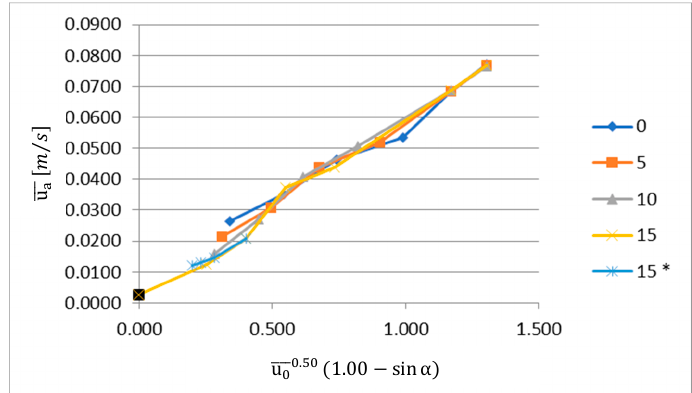
Figure 13. Relation between the average velocity at the opening and u (cid:2868) (cid:3364)(cid:3364)(cid:3364) (cid:2868).(cid:2873)(cid:2868) (cid:4666)1.00 (cid:3398) sinα(cid:4667) (15* values correspond to tests with variations in jet thickness).